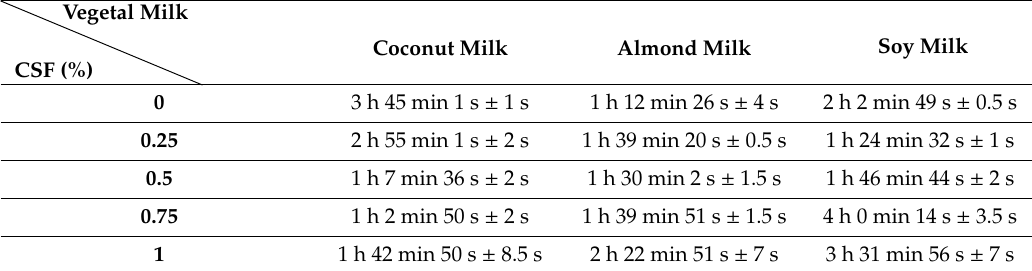
Table 1. Gel point time for di ff erent milk samples in function of carob seed flour